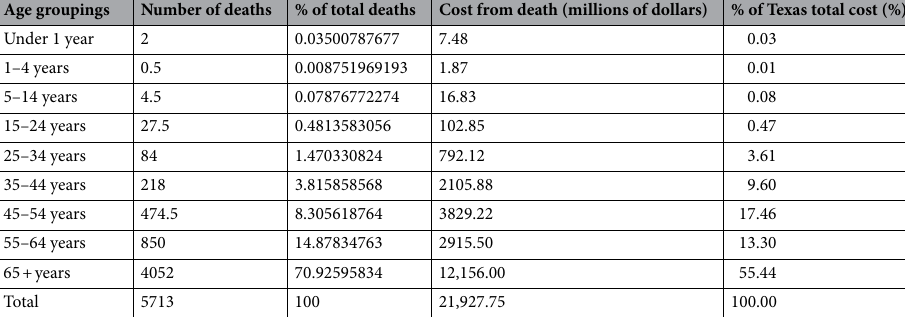
Table 3. Age-specific economic costs of COVID-19 deaths for the state of Texas. 0.5 deaths exist here because of artificial age group delineations. Texas reports deaths in 10-year age groups, i.e. 1–9 years, 10–19